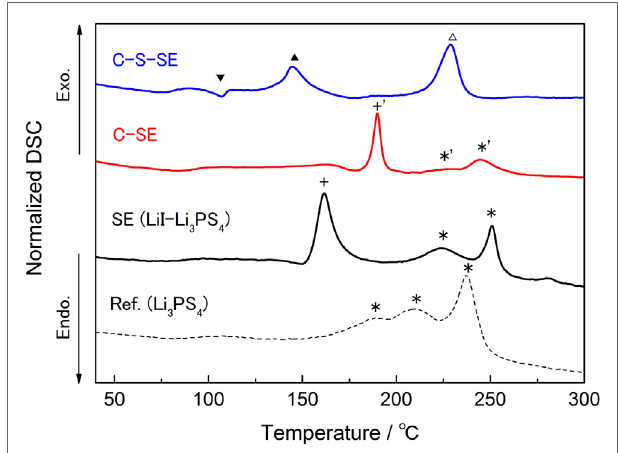
FigUre 8 | Dsc chart for the electrolytes and composites at the first heating . The heat flow was normalized by the sample weight. DSC scan rate was 2°C min − 1 . TaBle 3 | summary of the Dsc analysis of the samples.